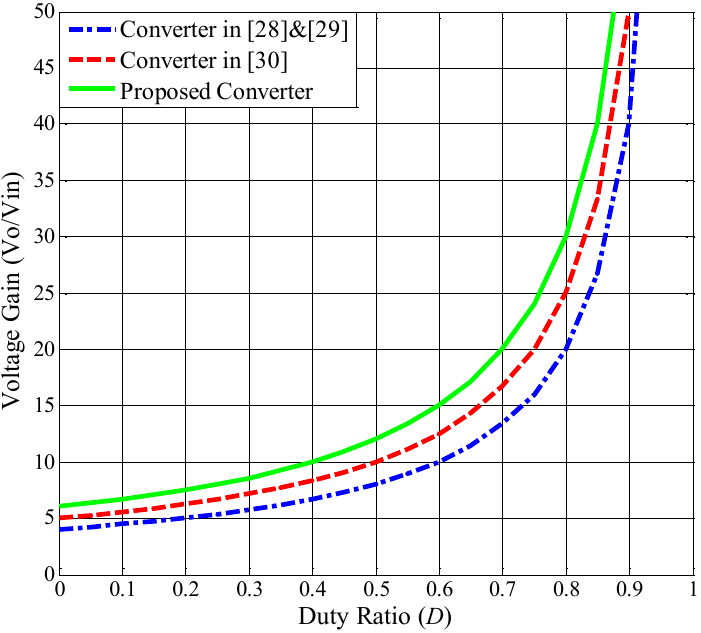
Figure 7 . Voltage gain comparison with turns ratio n = 1. Figure 7. Voltage gain comparison with turns ratio n = 1.